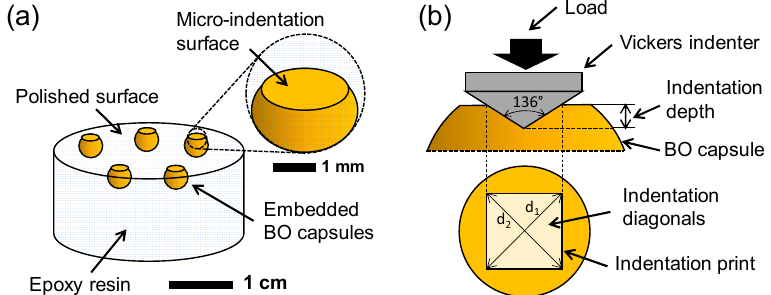
Figure 3. ( a ) Bio-oil (BO) capsules embedded in epoxy resin; ( b ) Vickers micro-indentation hardness testing. The Vickers micro-indenter is a square-based pyramidal-shape indenter made of diamond with an angle of 136 ◦ between opposite faces. A total of 40 tests were performed on BO capsules.